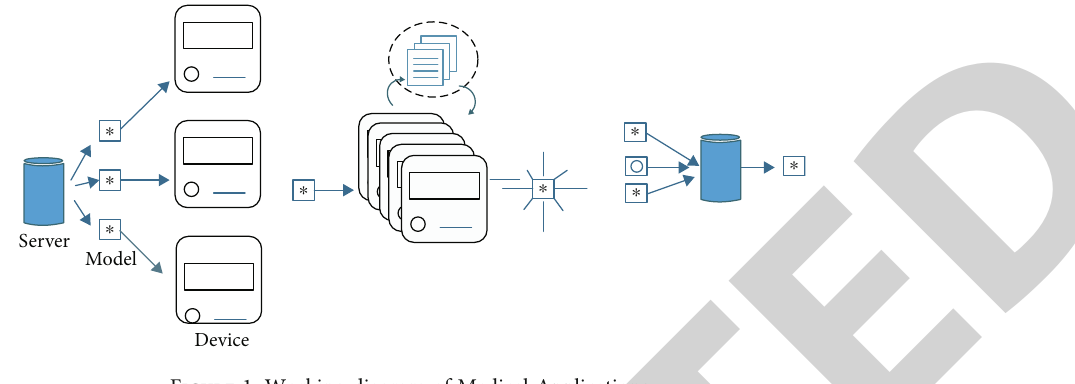
Figure 1: Working diagram of Medical